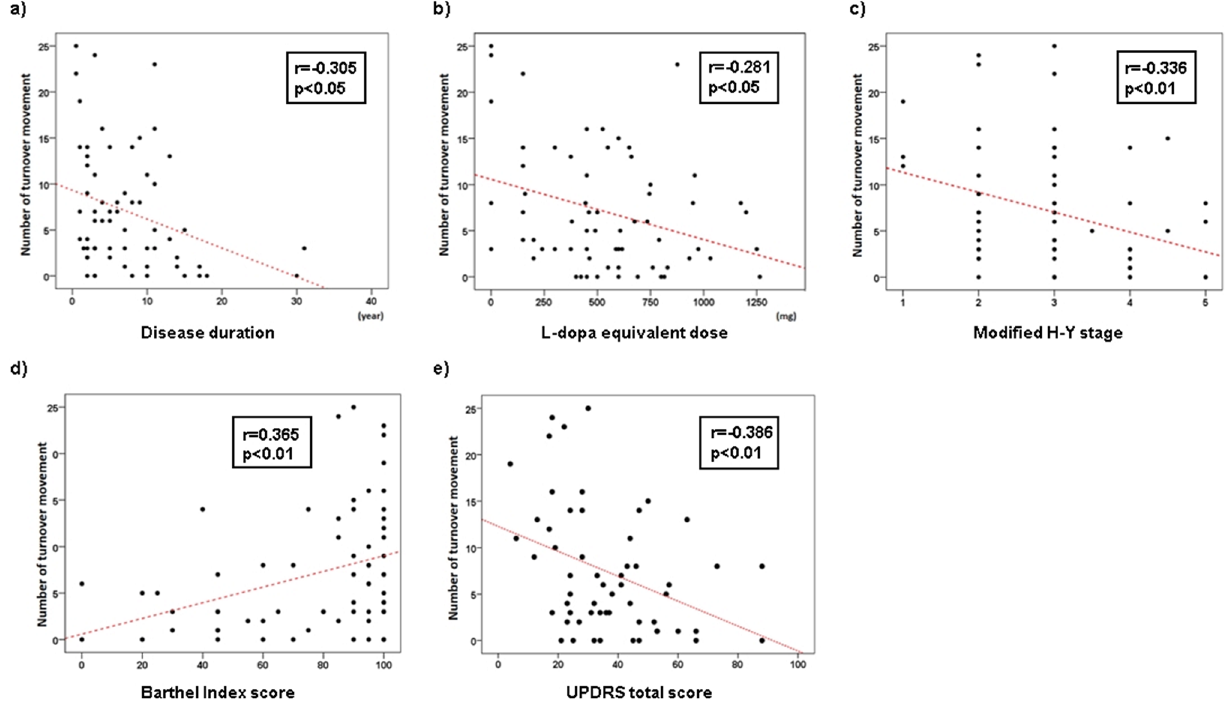
Fig 3. Correlations between number of turnover movements in bed and background factors. Number of turnover movements in bed correlatedsignificantly with diseaseduration(a), L-dopaequivalentdose (b), modified H-Y stage (c), B-I (d), and total UPDRS score (e).